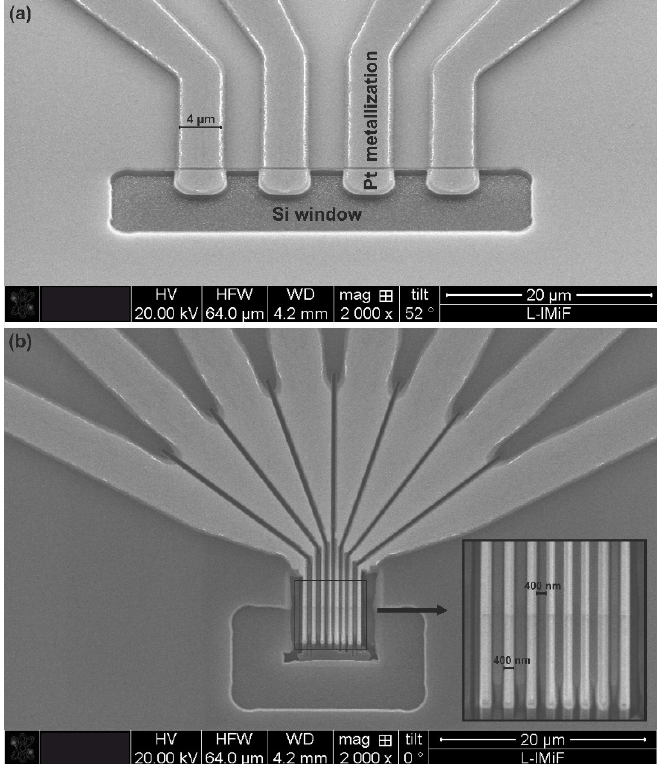
Figure 3. SEM image of the thermometric structures: ( a ) 4-microthermocouples (each 4 µm wide ) prepared without using FIB; and ( b ) thermocouples prepared with FIB. The separate and narrow (400 nm width) 8-thermocouples (in the form of separated strips) were fabricated by milling using gallium ion. The air gap between thermocouples was about 400 nm. Each of the fabricated thermocouples has a separate electrical connection.